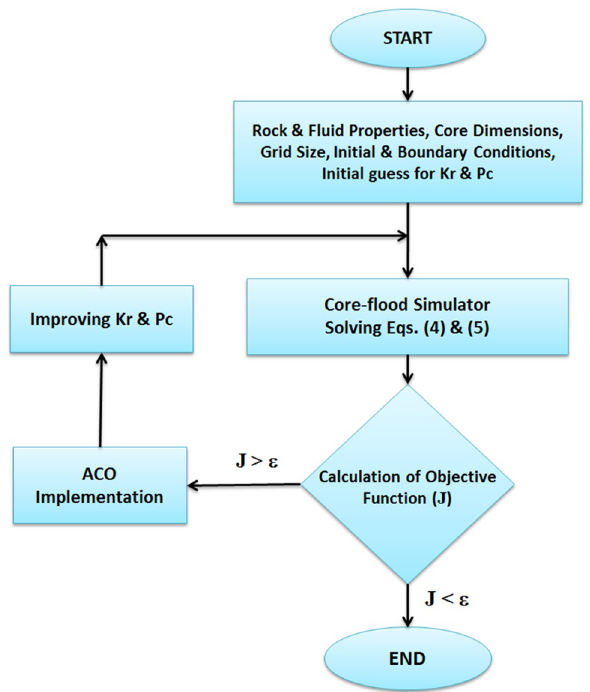
Fig. 2 Estimation of k P r and c using ACO optimization technique Reproduced with permission from Yaralidarani and Shahverdi (2016)